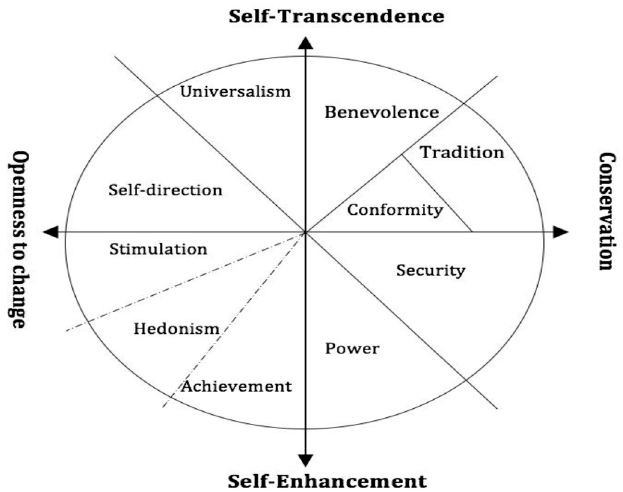
Figure 2. Schwartz’s model of motivational types of values Source: Bardi and Schwartz